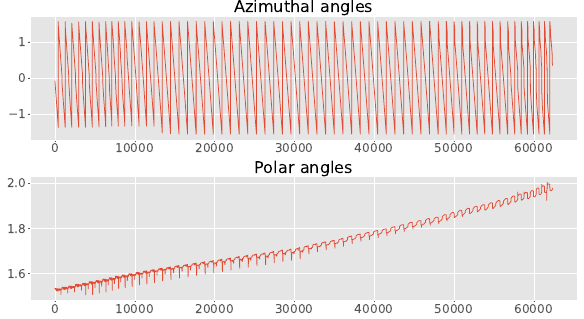
Figure 4. Plot containing the azimuths and vertical angles for a single point cloud.